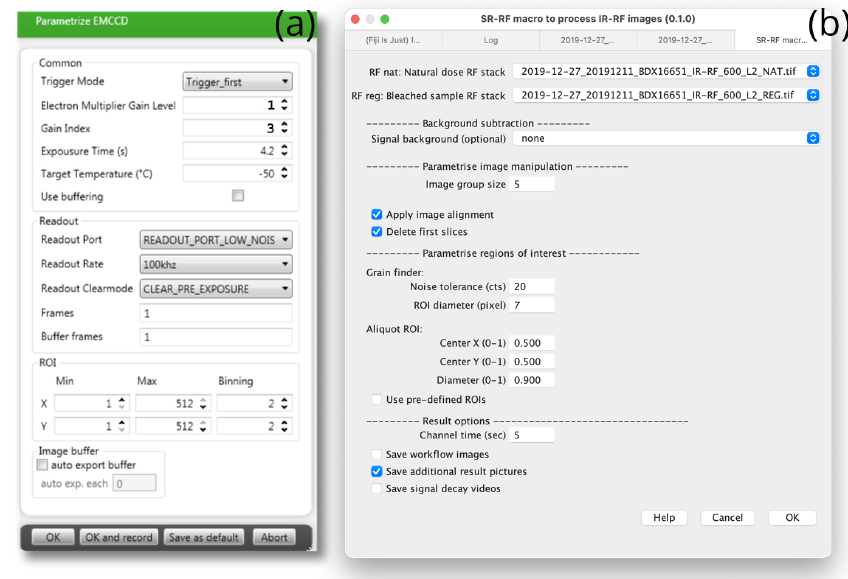
Figure 2. Screenshots of (a) the LexStudio 2 interface to parameterise the CCD camera and (b) the SR-RF ImageJ macro interface to analyse IR-RF images. Table 1. Applied IR-RF measurement sequence according to the RF 70 protocol by Frouin et al. (2017). No. Step Treatment Measurement 1 Shallow trap depletion Preheat at 70 ◦ C for 900s – 2 Natural dose IR-RF β irradiation at 70 ◦ C for <user defined time> RF nat 3 Signal resetting Bleaching with in-built solar simulator for 3h – 4 Wait for phosphorescence to decay Pause for 1h – Shallow trap depletion Preheat at 70 ◦ C for 900s – 6 Regenerative dose IR-RF β irradiation at 70 ◦ C for <user defined time> RF